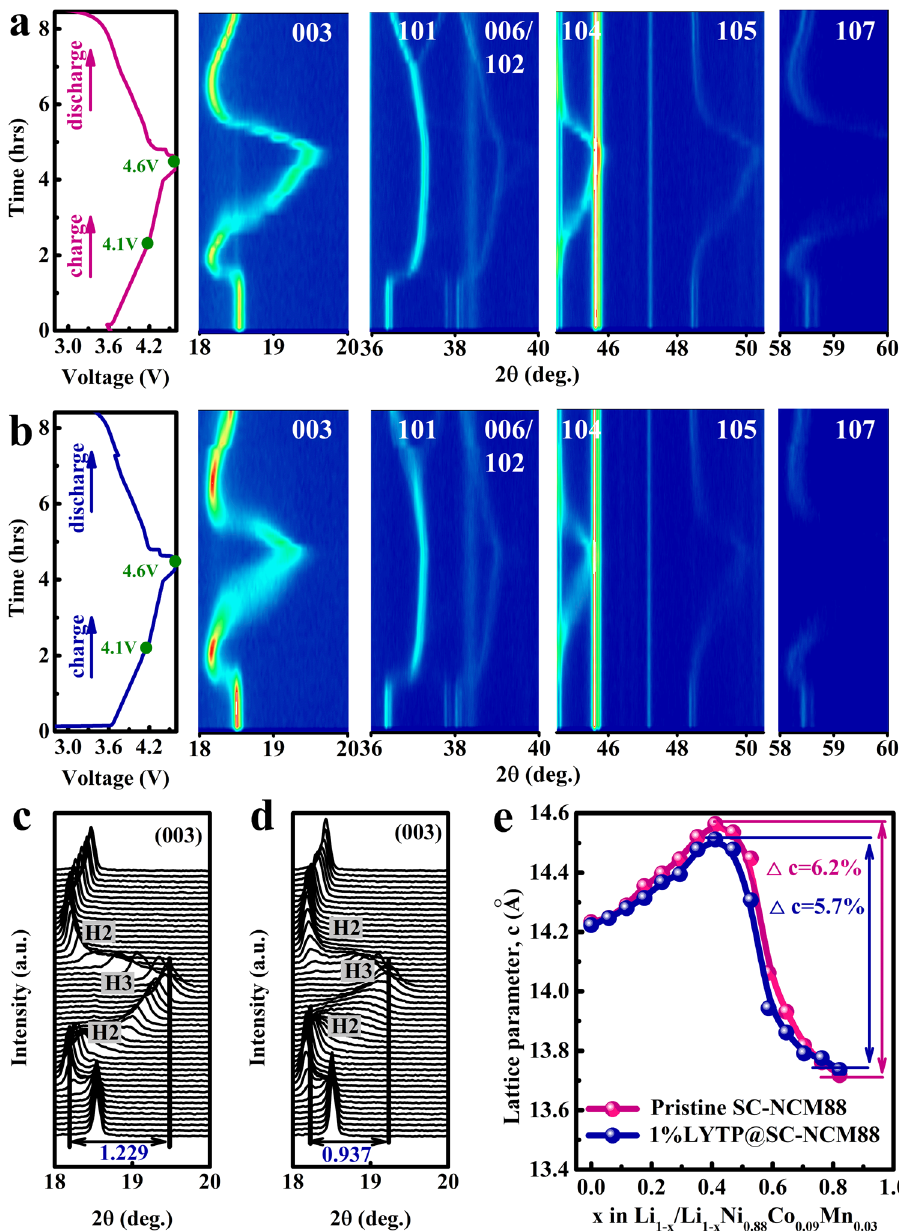
Fig. 6 Investigation of phase transitions during cycling. Operando XRD characterization of the full contour plots and selected line patterns for ( a , c ) SC- NCM88 and ( b , d ) 1% LYTP@SC-NCM88 cathodes during the initial cycle in the voltage range of 2.75-4.6V. e The variation of the c -axis parameter during charging for pristine SC-NCM88 and 1%